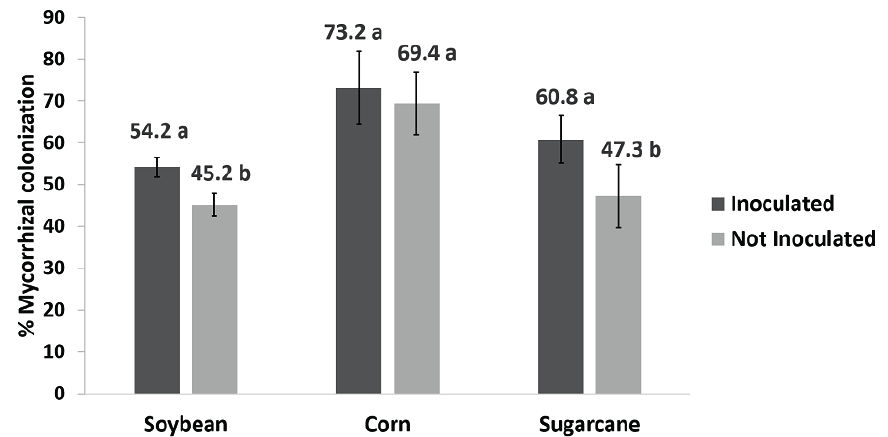
Figure 1 - Mycorrhizal colonization as percentage in soybean, sugarcane, and corn inoculated and uninoculated with the fungi Beauveria bassiana, Metarhizium anisopliae, Pochonia chalamydosporia, Purpureocillium lilacinum, and Trichoderma asperella .